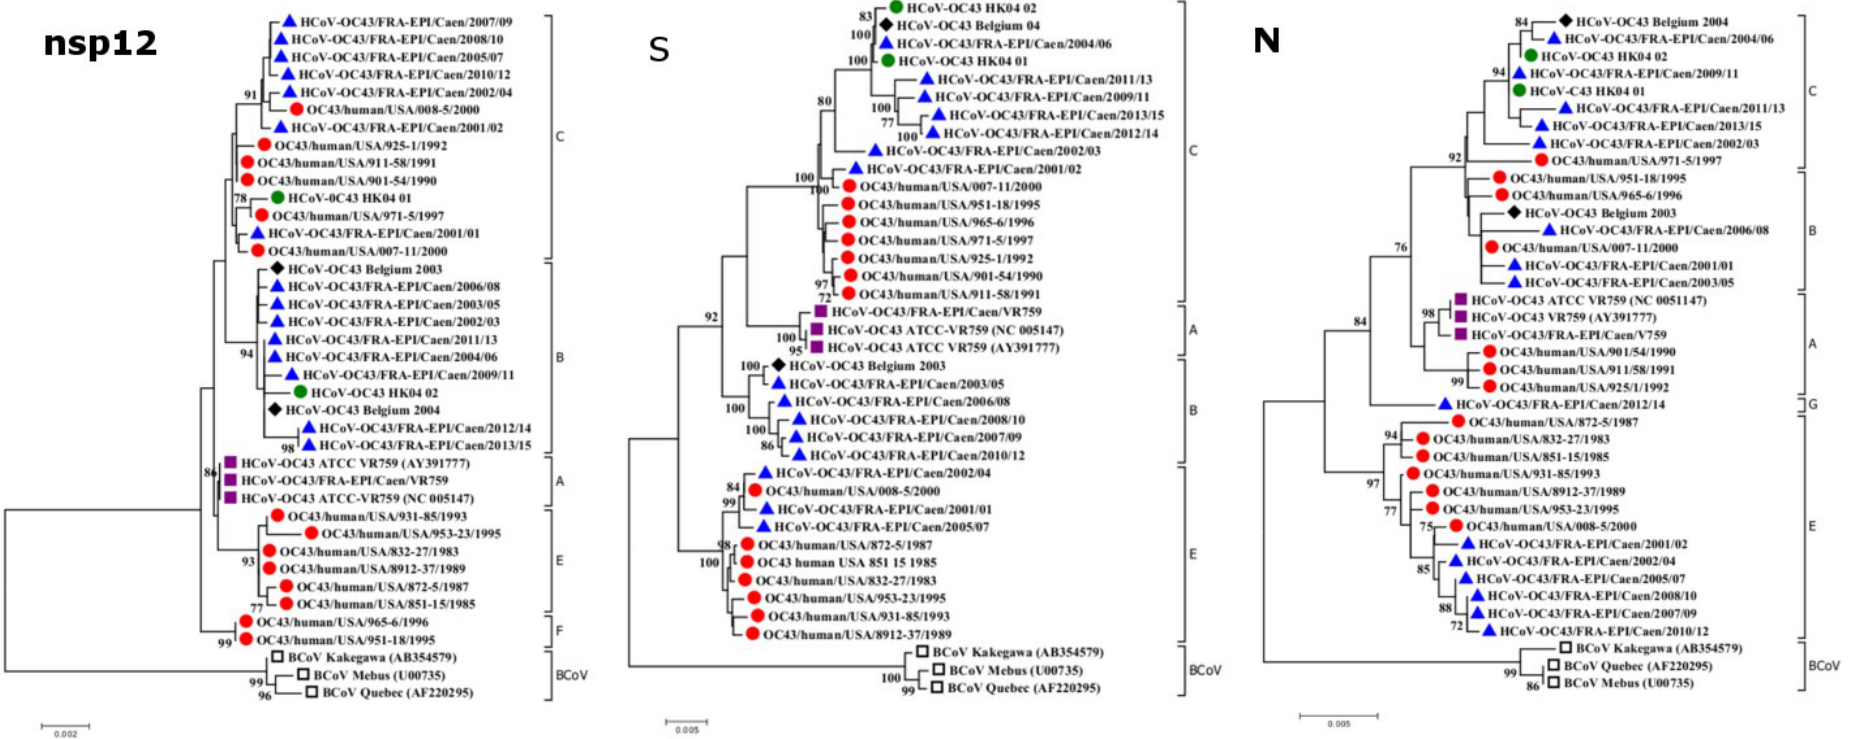
Figure 1. Phylogenetic analysis of the complete nsp12, S, and N genes of the 36 HCoV-OC43 strains and 3 BCoV strains. The phylogenetic trees were constructed by the neighbor joining method [35]. Bootstrap values were calculated from 1000 replicates. Bootstrap values over 70% are shown [40]. The evolutionary distances were computed using the Kimura 2-parameter method (kimura) and units are the number of base substitutions per site. Evolutionary analyses were conducted in MEGA, version 6.06. [41]. Blue triangle, isolates from Caen; red circle, isolates from USA; green circle, isolates from Hong-Kong; black diamond, isolates from Belgium; purple square, ATCC-VR759 strains, empty black square, BCoV